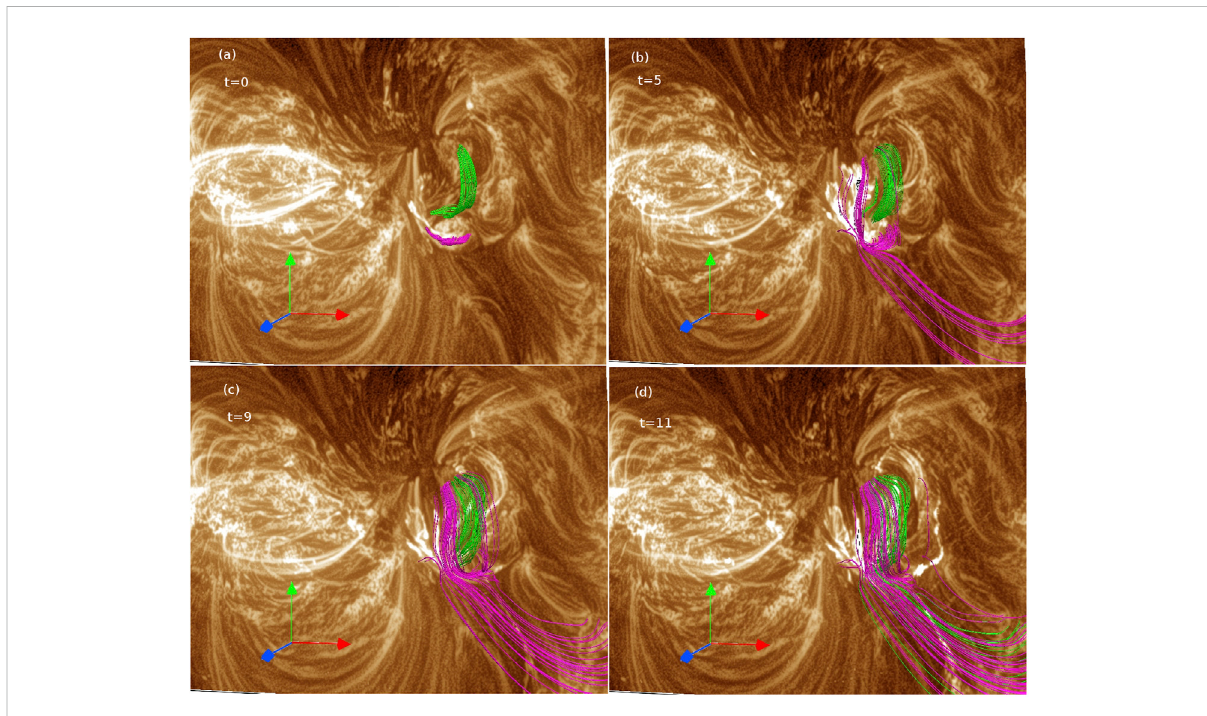
FIGURE 10 Here the dynamics of the fi lament associated rope (in green) and the magenta-colored rope (as in Figure 8) are overplotted with the cotemporal193 Å observations. Panel (A) shows the initial state. Reconnection of the magenta fi eld lines is evident in panel (B) . The post- reconnected fi eld lines of both the ropes match well with the bright structures extending along the right bottom inthe observational images [panels (C and D)